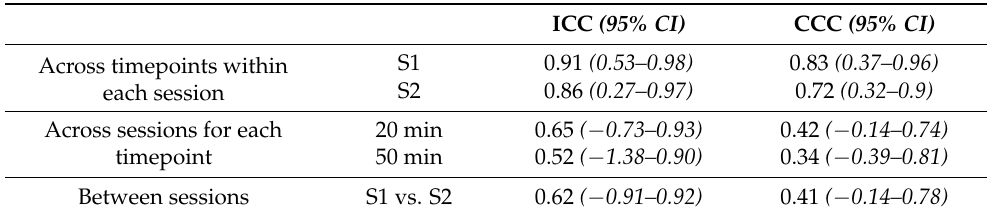
Table 4. ICCs and CCCs used in the regression analysis for Study 2. In parenthesis is the 95% confidence interval.